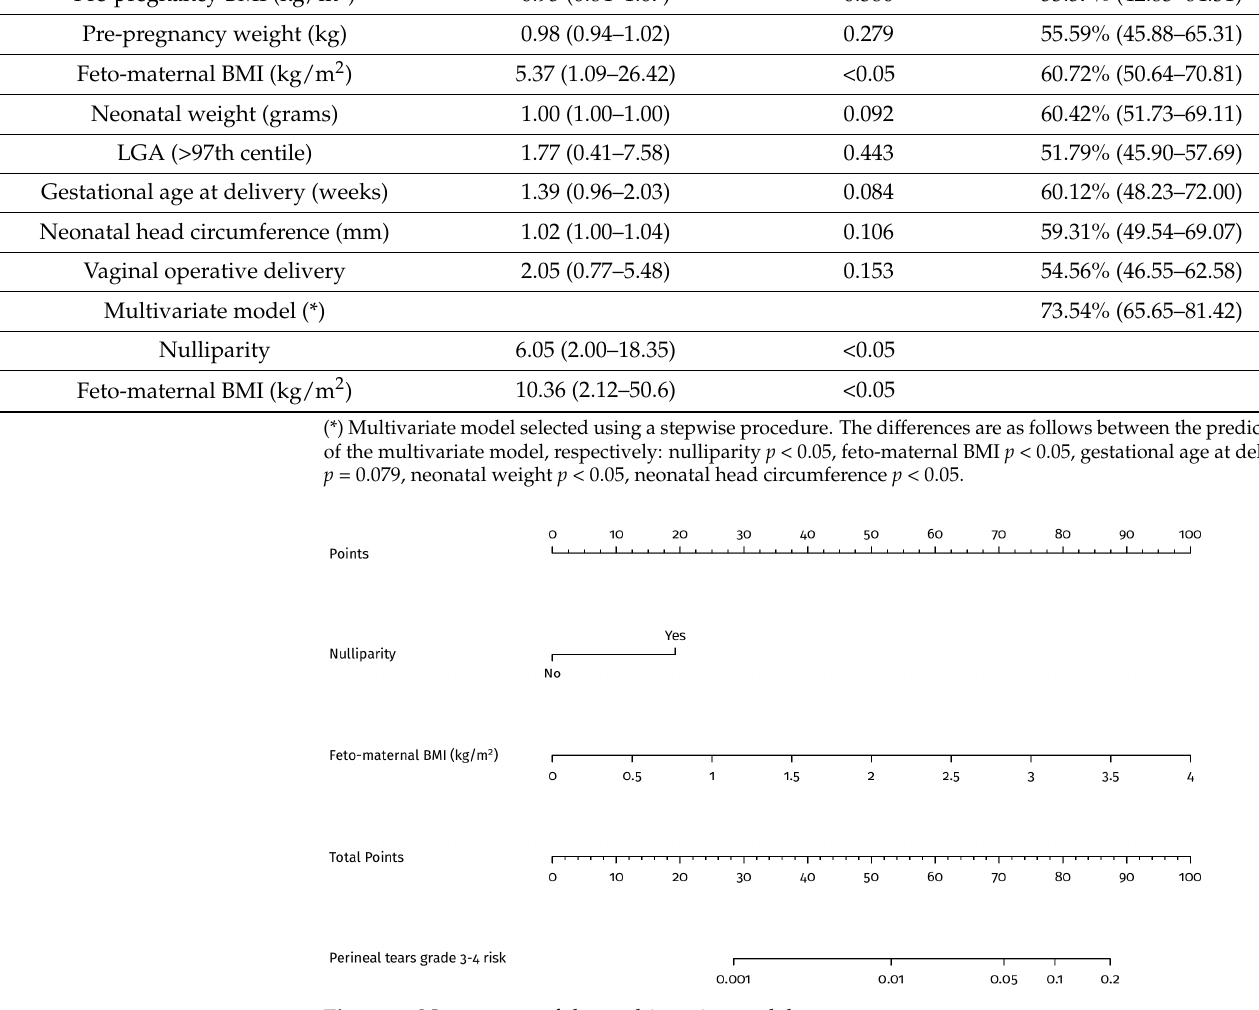
Figure 2. Nomogram of the multivaraite model.